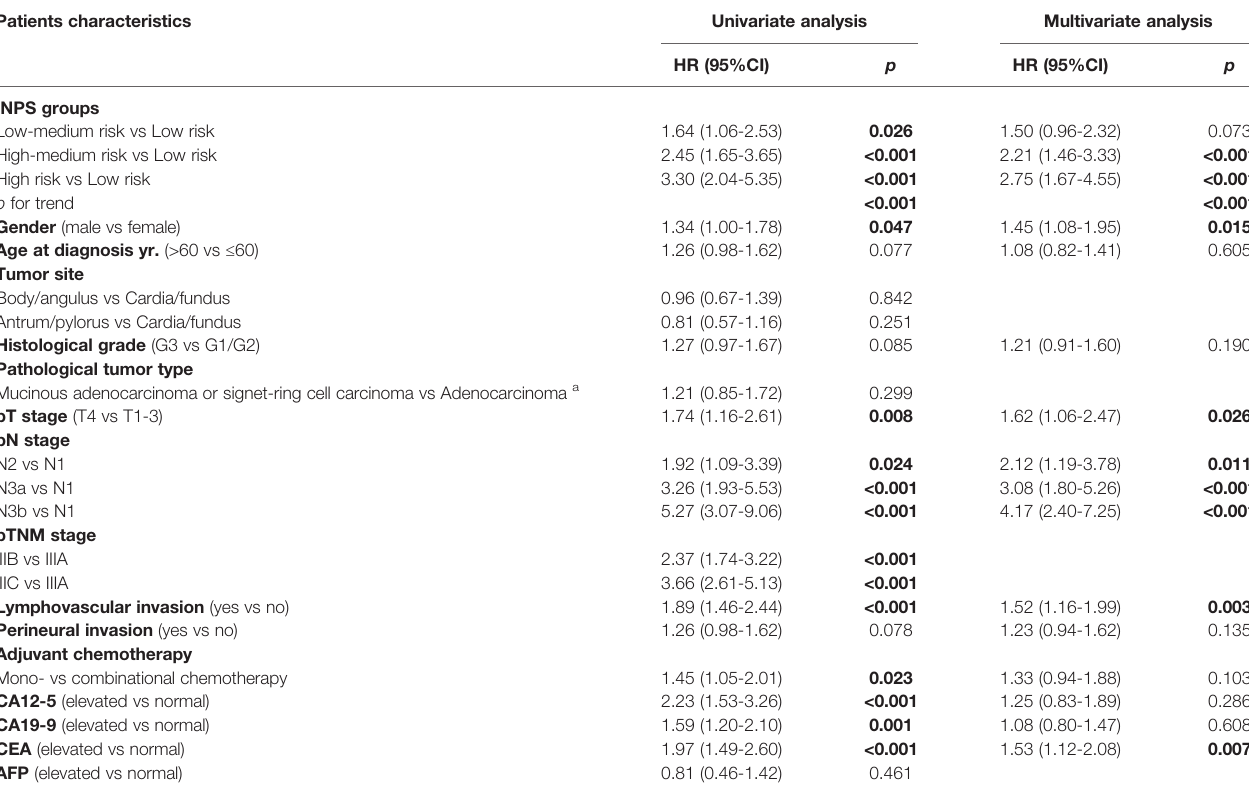
TABLE 2 | Univariate and multivariate analyses of baseline characteristics and INPS groups for overall survival in 513 GC patients. Patients characteristics Univariate analysis Multivariate analysis HR